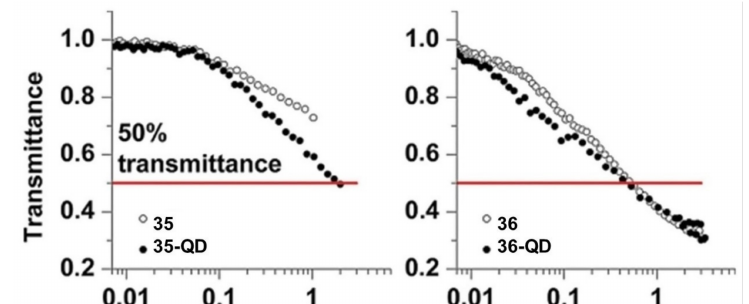
Figure 16. Transmittance of sandwich complexes and their conjugates with QDs depending on the incident fluence, performed at a pulse rate of 10 ns and I 0 ≈ 0.33 GW/cm 2 . The red solid line corresponds to 50% transmittance (limiting threshold). Adapted with permission from ref